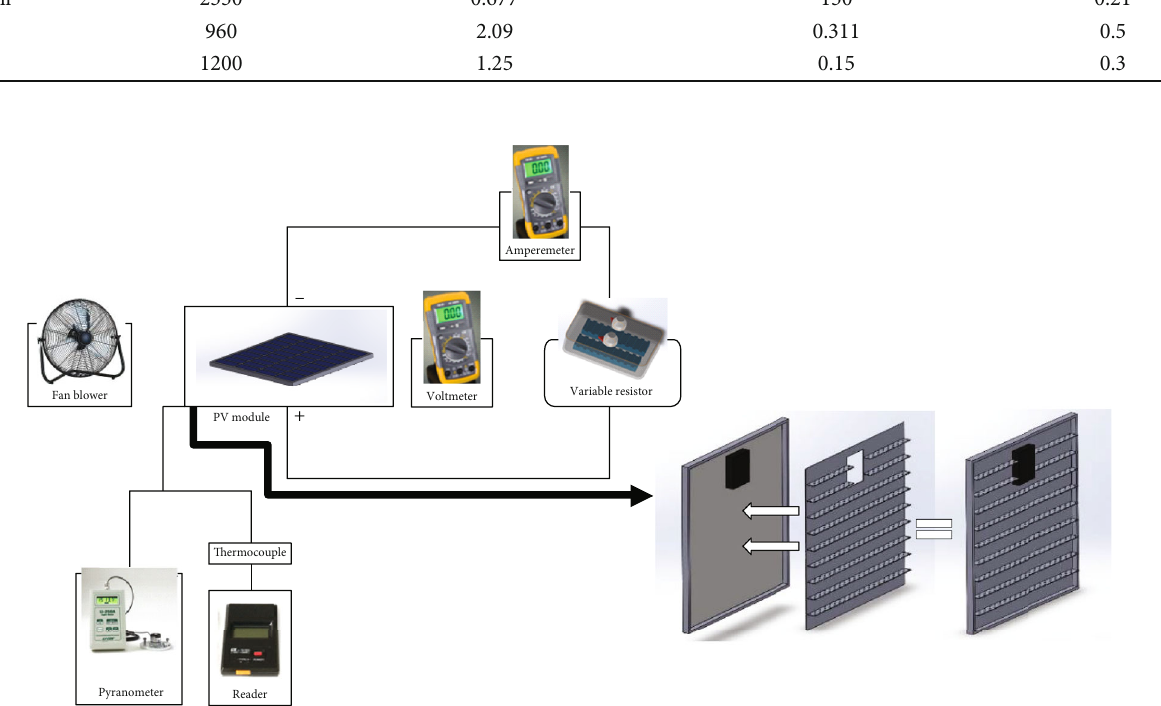
Figure 2: Schematic con fi guration of the PV panel with heat